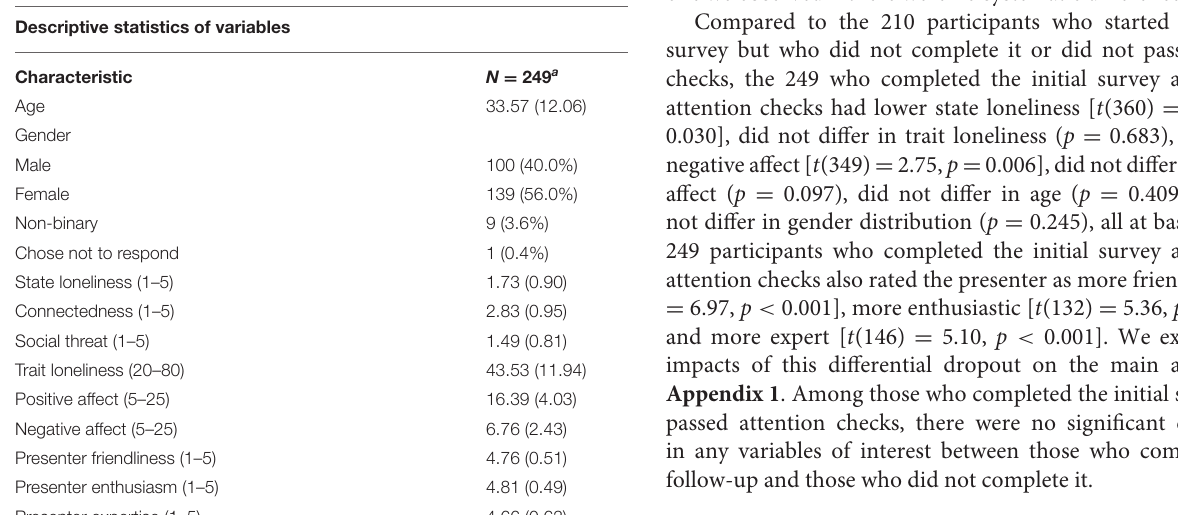
TABLE 1 | Descriptive statistics, all measured at baseline except for presenter friendliness, enthusiasm, and expertise, which were evaluated after the